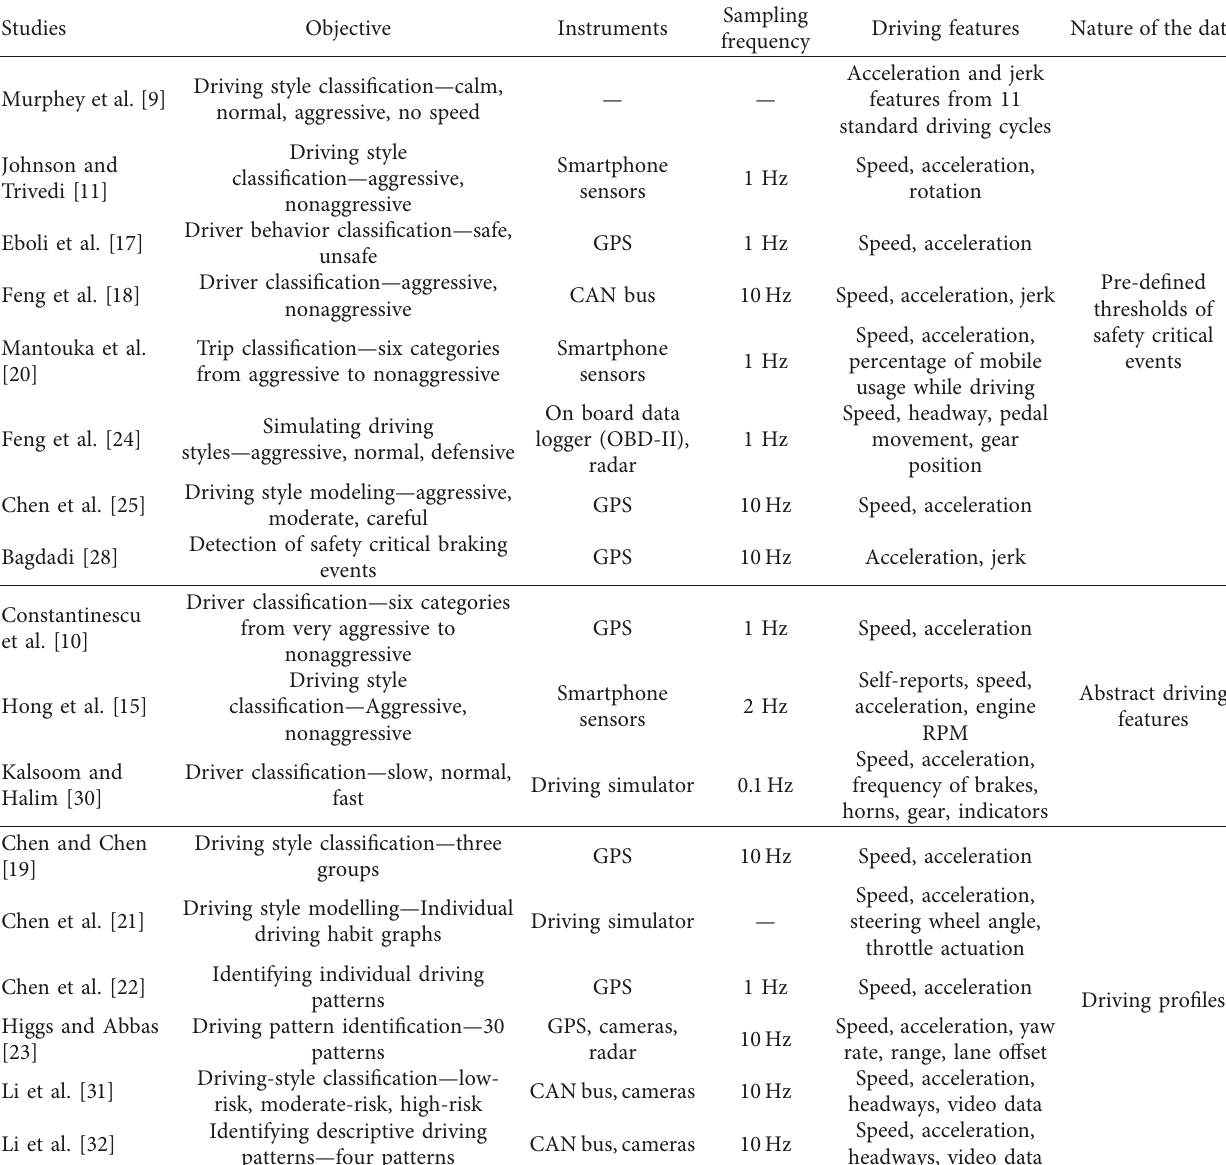
Table 1: Summary of the literature on driving style